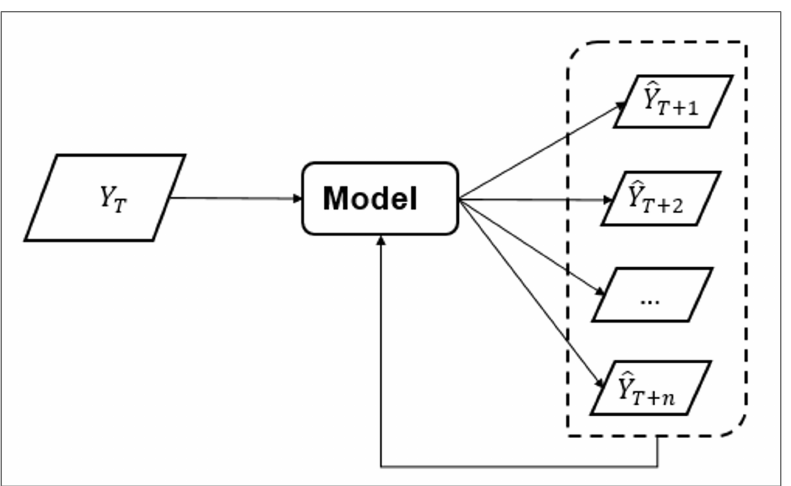
Figure 6. Multistep prediction